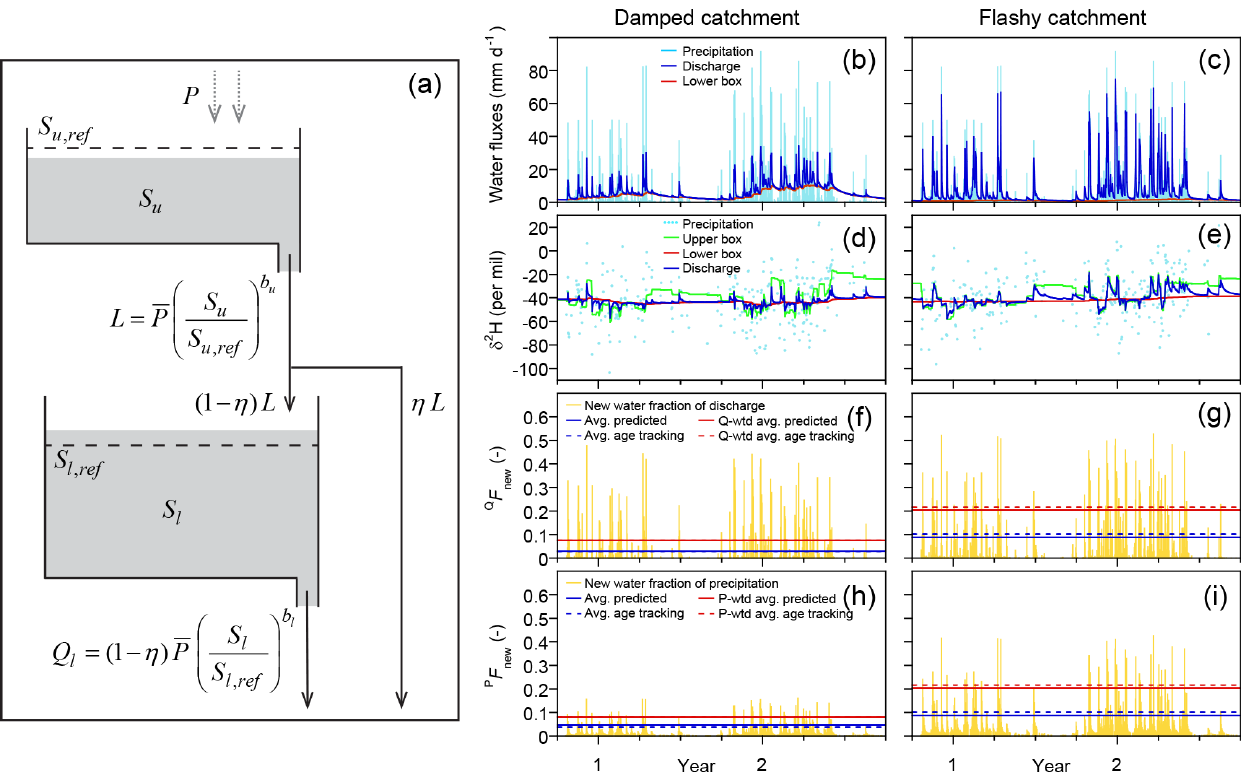
Figure 1. Schematic diagram of the benchmark model (a) , with 2-year excerpts from illustrative simulations of its behavior (b–i) . Model parameters for simulations of damped catchment response (b, d, f, h) are S u, ref = 100mm, S l, ref = 1000mm, b u = 10, b l = 3, and η = 0 . 3. For simulations of flashy catchment response (c, e, g, i) , all but one of the parameters are the same; only η is changed to 0.8 and a different random realization of precipitation isotopes is used. The same daily precipitation time series (Smith River, Mediterranean climate) is used in both cases. The isotopic composition of streamflow exhibits complex dynamics over multiple timescales (blue line in d, e ), as dominance shifts between the upper and lower boxes (green and orange lines, respectively, in d, e ). Like the discharge and its isotopic composition, the fraction of discharge comprised of same-day precipitation (the new water fraction of discharge, Q F new , f, g ) exhibits complex nonstationary dynamics. Nonetheless, its long-term average (dashed blue line) is well predicted by ensemble hydrograph separation (solid blue line); the same is true of the discharge-weighted average (dashed and solid red lines). The fraction of precipitation appearing in same-day discharge (the forward new water fraction, P F new , h, i ) is somewhat less variable, but both its average and precipitation-weighted average are also well predicted by ensemble hydrograph separation (solid and dashed blue and red lines). In several cases the dashed and solid lines cannot be distinguished because they